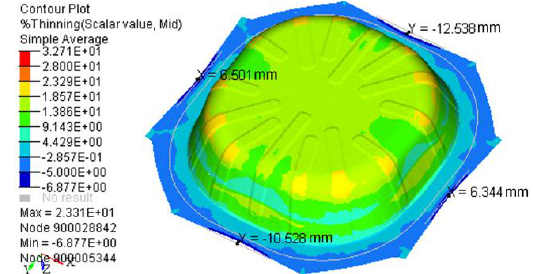
Figure 10. % Thinning distribution and X1, X2, Y1 and Y2 values for the RUN20; blank0.